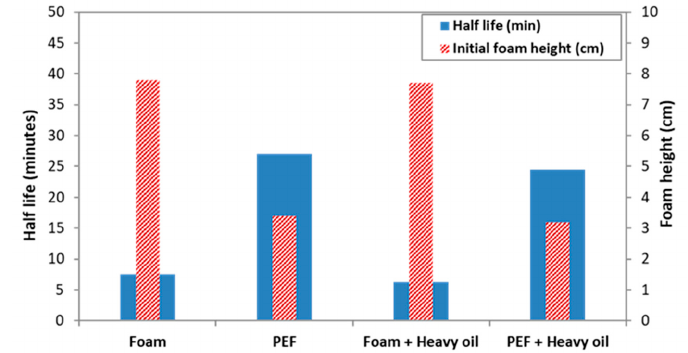
Figure 4. Bulk foamability and stability (half-life) of foam and polymer enhanced foam (PEF) in the presence and the absence of heavy crude oil.